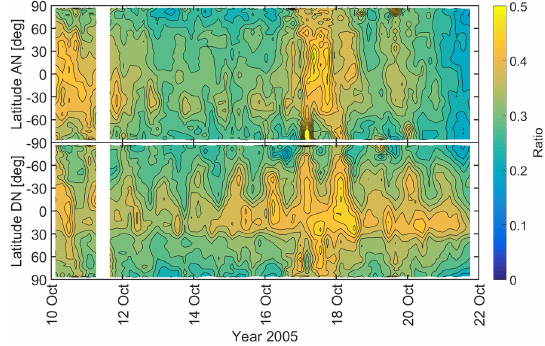
Figure 16. Electron density ratio (GITM / CHAMP) as a function of time and latitude for “case a” (LTAN = 15:10; LTDN = 03:10).